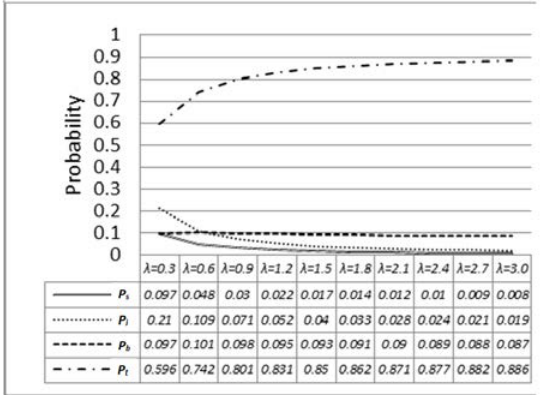
Figure 5: Data input rate( λ ) and the variation of probability in different